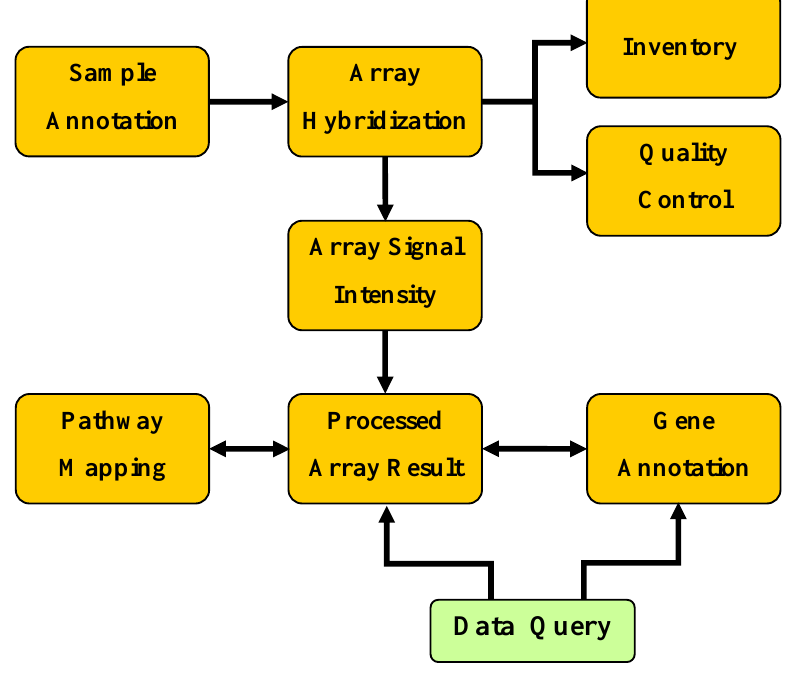
Figure 1: The data flow of Goober microarray package. Each component or module in the package is represented by a square box, and direction of data flow is indicated by the arrow. The data query, which is shown in green box, represents the web interface to access the